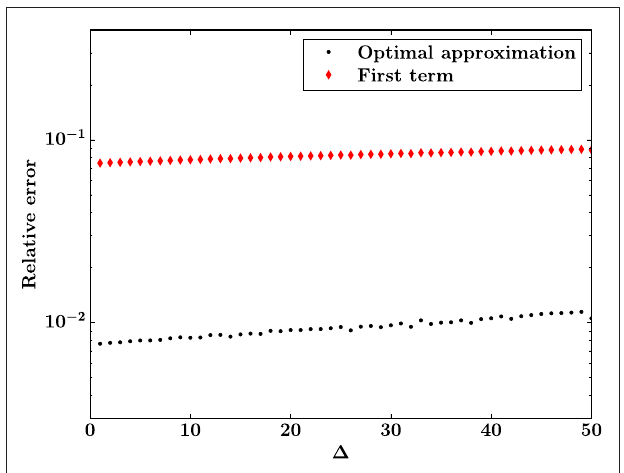
FIGURE 9 | Relative errors for the burst distribution with respect to simulation results that are averaged over 10 6 sample systems of size N optimal approximation from Equation (44) with 13 available terms (black) and for the first term of the asymptotic series (red), which is Equation (4). The threshold distribution is uniform on